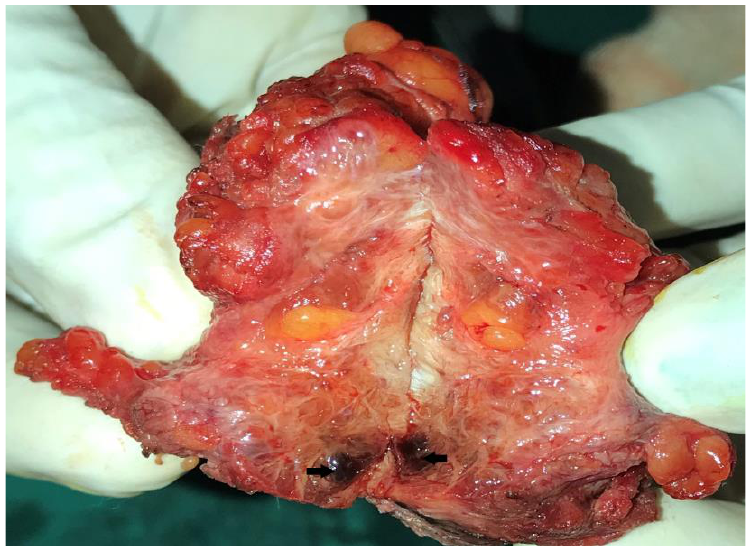
Figure 3. The cut surface was grayish-white to solid brown homogeneous area with focal blackish discoloration.